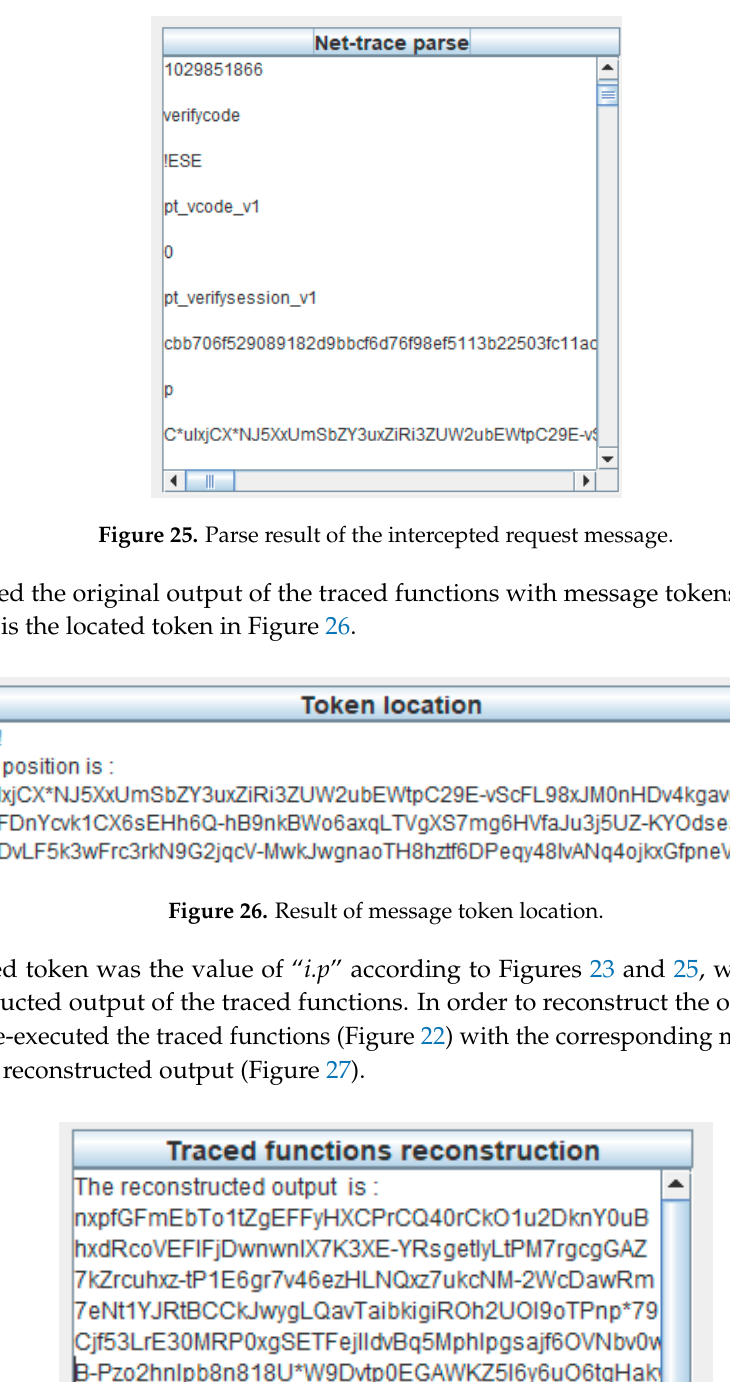
Figure 24. Response message.